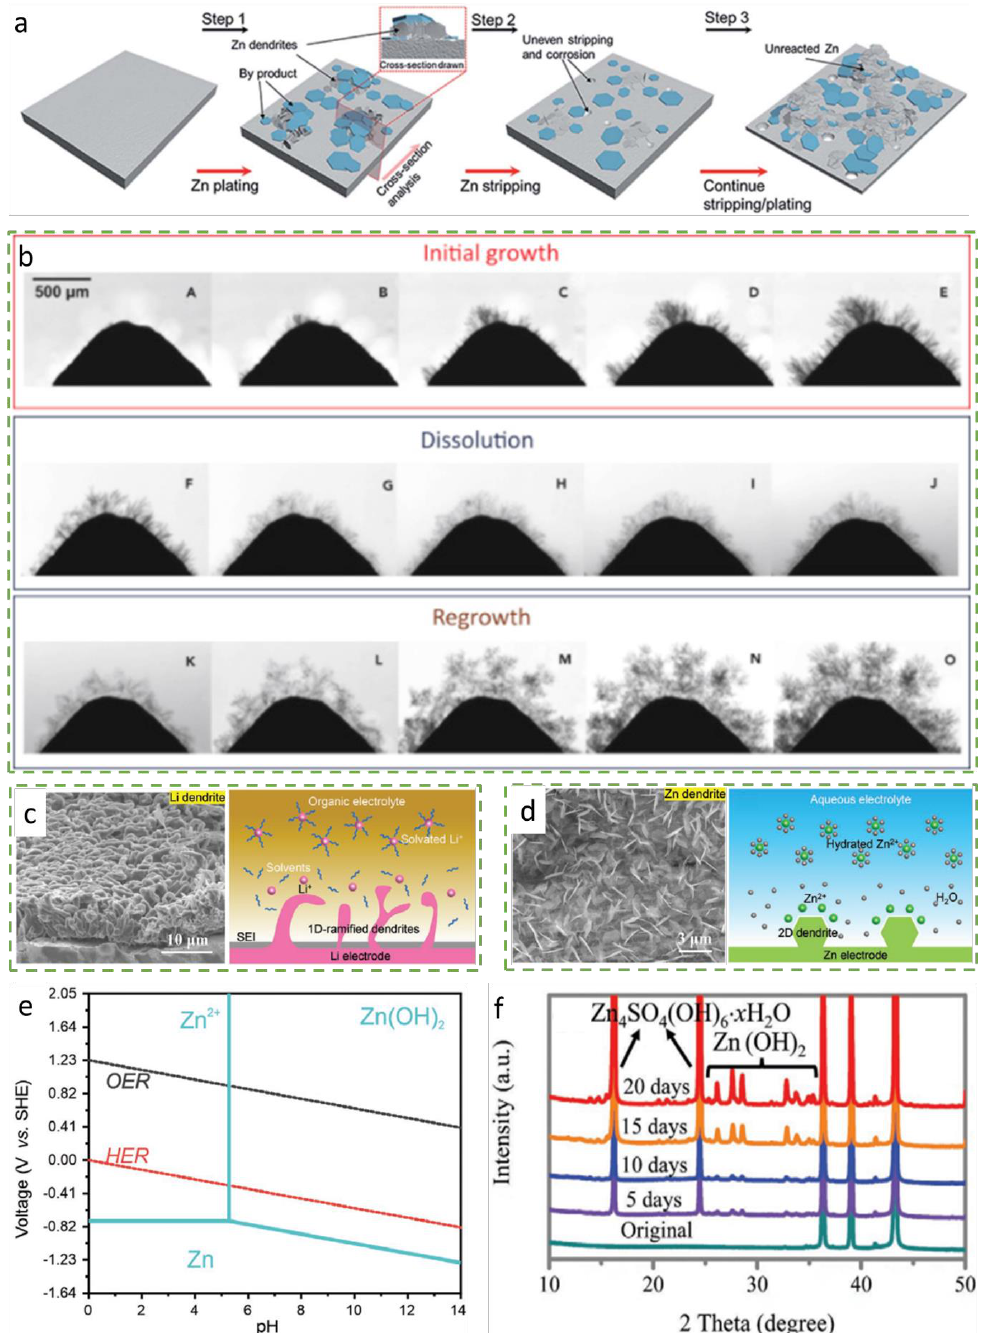
Figure 3. ( a ) Schematic illustration of the formation of inactive “dead” Zn (Reproduced with permission [41] Copyright 2021, Royal Society of Chemistry). ( b ) Operando optical microscopic study of Zn dendrite growth, dissolution, and regrowth in aqueous electrolytes (Reproduced with permission [44] Copyright 2019, Elsevier). ( c ) SEM image of Li dendrites and schematic diagram of dendrite topolo- gies (Reproduced with permission [35] Copyright 2020, John Wiley & Son and Reproduced with permission [45] Copyright 2016, American Chemical Society). ( d ) SEM image of Zn dendrites and schematic diagram of dendrite topologies (Reproduced with permission [35] Copyright 2020, John Wiley & Son). ( e ) Pourbaix diagram of Zn in a 2 M ZnSO 4 solution (Reproduced with permission [46] Copyright 2021, John Wiley & Son). ( f ) XRD patterns of Zn immersed in 2 M ZnSO 4 electrolyte for different periods (Reproduced with permission [47] Copyright 2021, John Wiley &